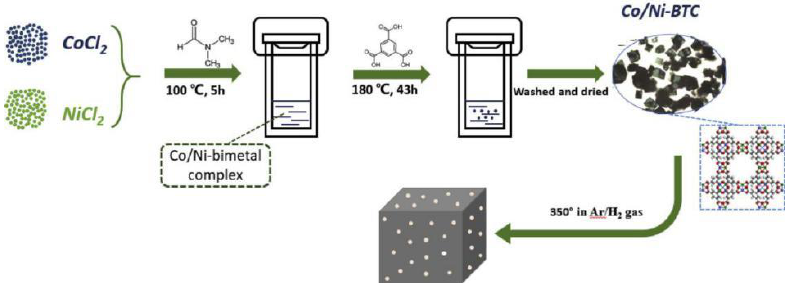
Figure 3. Schematic illustration of the synthetic route for Co/Ni-350. Reproduced with permission from [64]. Copyright 2019 International Journal of Hydrogen Energy .